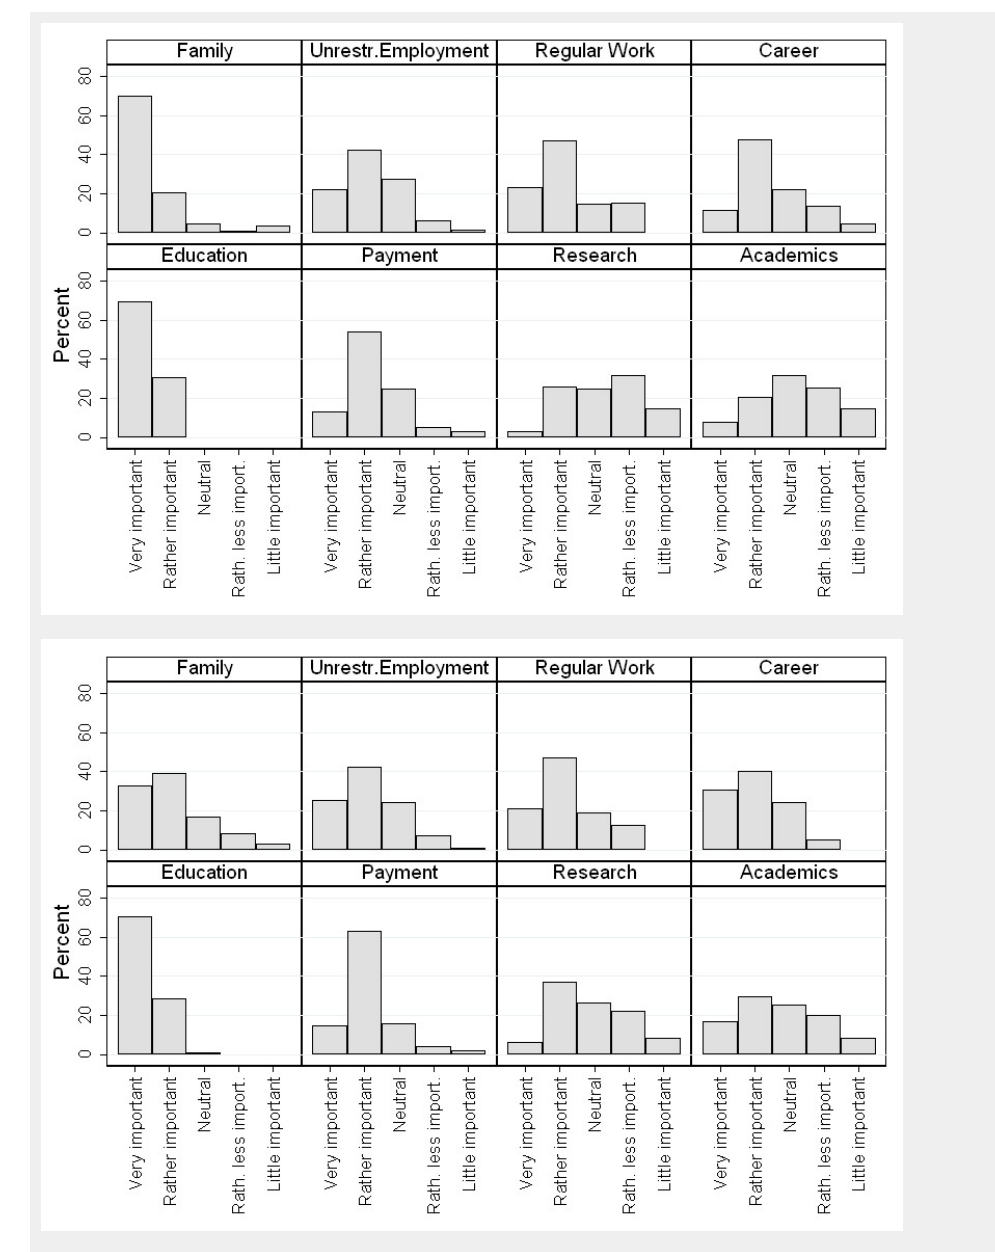
As a doctor, how important are the following aspects regarding future work environments to you: good work-life balance (family), unrestricted employment (unrest. employment), regular work, good career chances (career), optimal education (education), adequate payment